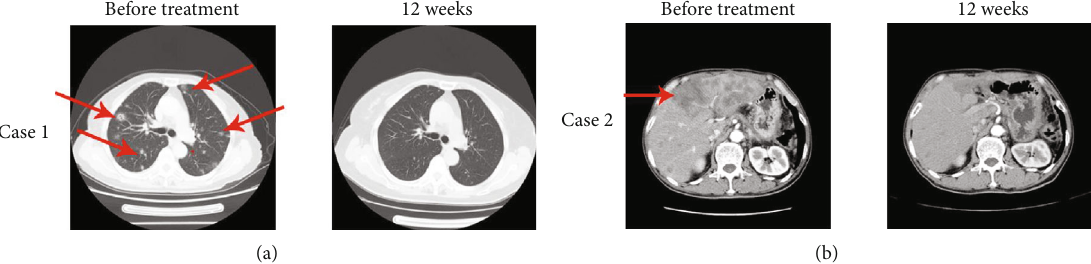
Figure 3: Two complete responses of patients with TIL therapy combined with anti-PD1 therapy. (a) A 15-year-old patient with lung metastasis experienced a complete response (CR) after 12 weeks of TIL therapy plus anti-PD1 therapy. The red arrow points at the target lesions before treatment. (b) A 20-year-old patient with liver metastasis experienced a complete response (CR) after 12 weeks of TIL therapy plus anti-PD1 therapy. The red arrow points at the target lesions before treatment.